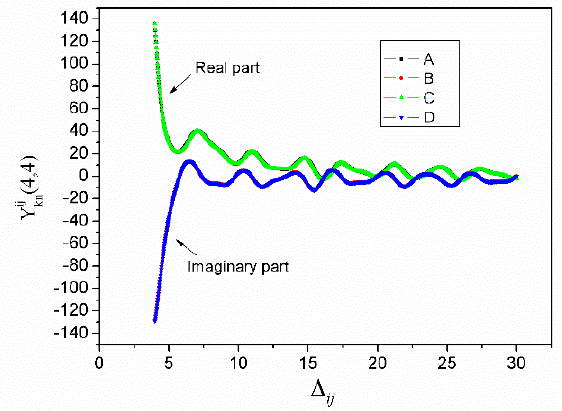
Figure 5. Calculated results of Y ij with two algorithms. Curve A and curve B are the results calculated kn using our algorithm, and curve C and curve D are the results calculated using adaptive